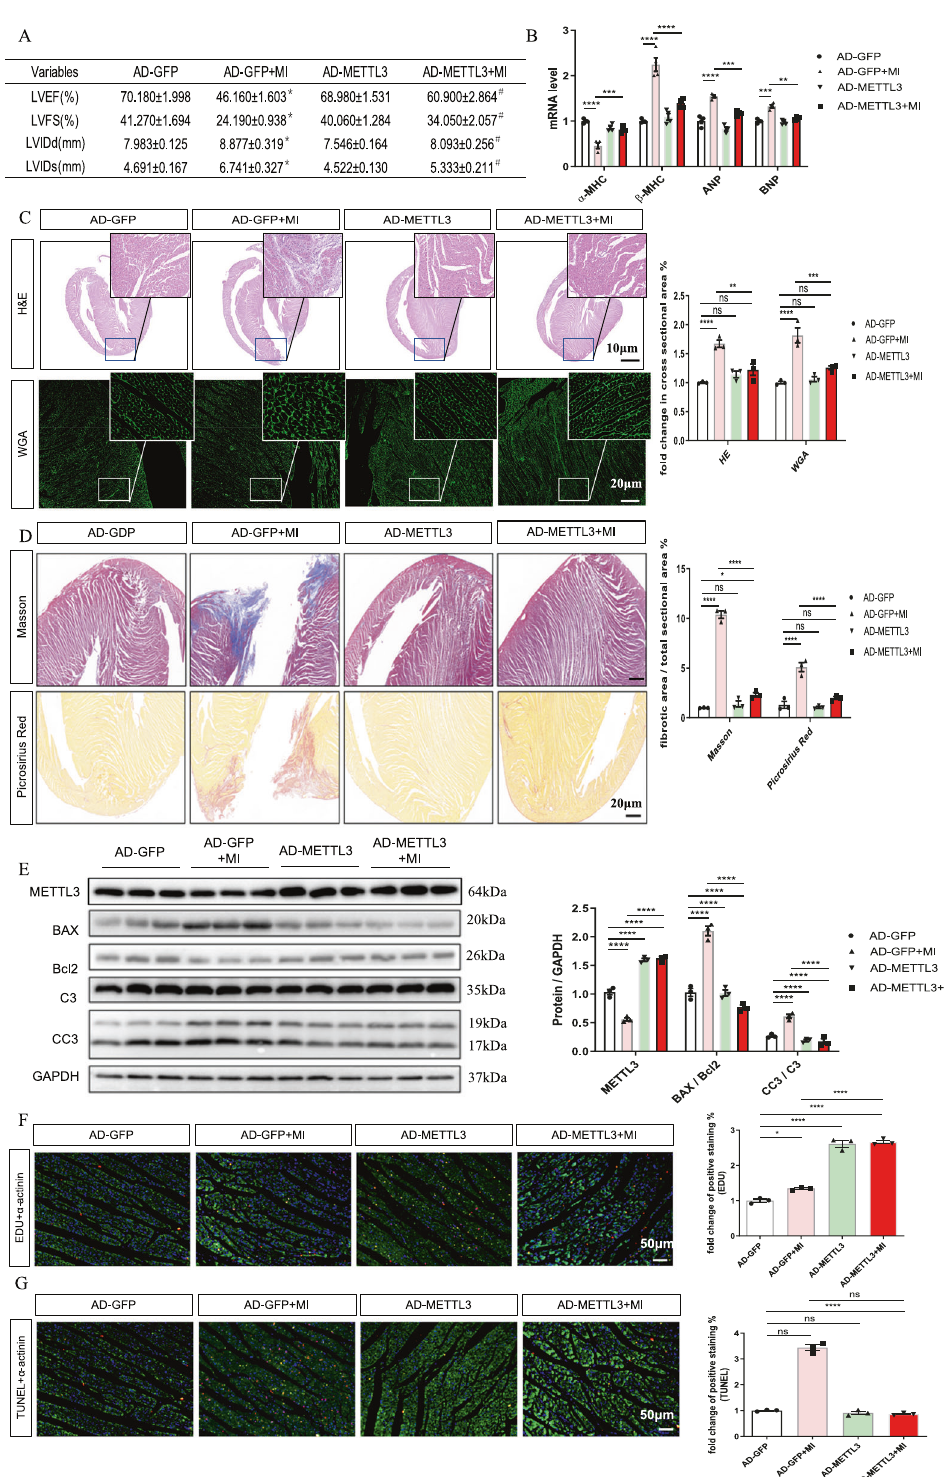
Fig. 4 METLL3 overexpression increases proliferative capacity and decreases apoptosis upon myocardial infarction (MI) in rats. A Echocardiographic data of left ventricular function, n = 5. B mRNA levels of α -MHC, β -MHC, ANP, and BNP in rats from indicated groups, n = 5. C Representative images of non-infarcted left ventricular myocardium sections stained with wheat germ agglutinin (WGA, top), and hematoxylin-eosin (HE, bottom) from indicated groups. Scale bar, 500 μ m. D Representative images of LV sections stained with Masson (top), and picrosirius red (bottom) from different groups. Scale bar, 50 μ m. E Protein expression of METTL3, BAX, Bcl2, C3, and CC3 in the AC16 from indicated groups, n = 3. F , G Representative immuno fl uorescence images of non-infarcted left ventricular myocardium sections labeled with EDU ( F ) or TUNEL ( G ) ( α -actinin, green; EDU or TUNEL, red; DAPI, blue. Scale bars, 50 μ m) and the corresponding quantitative analysis, n = 3. The results are expressed as the mean ± SD.